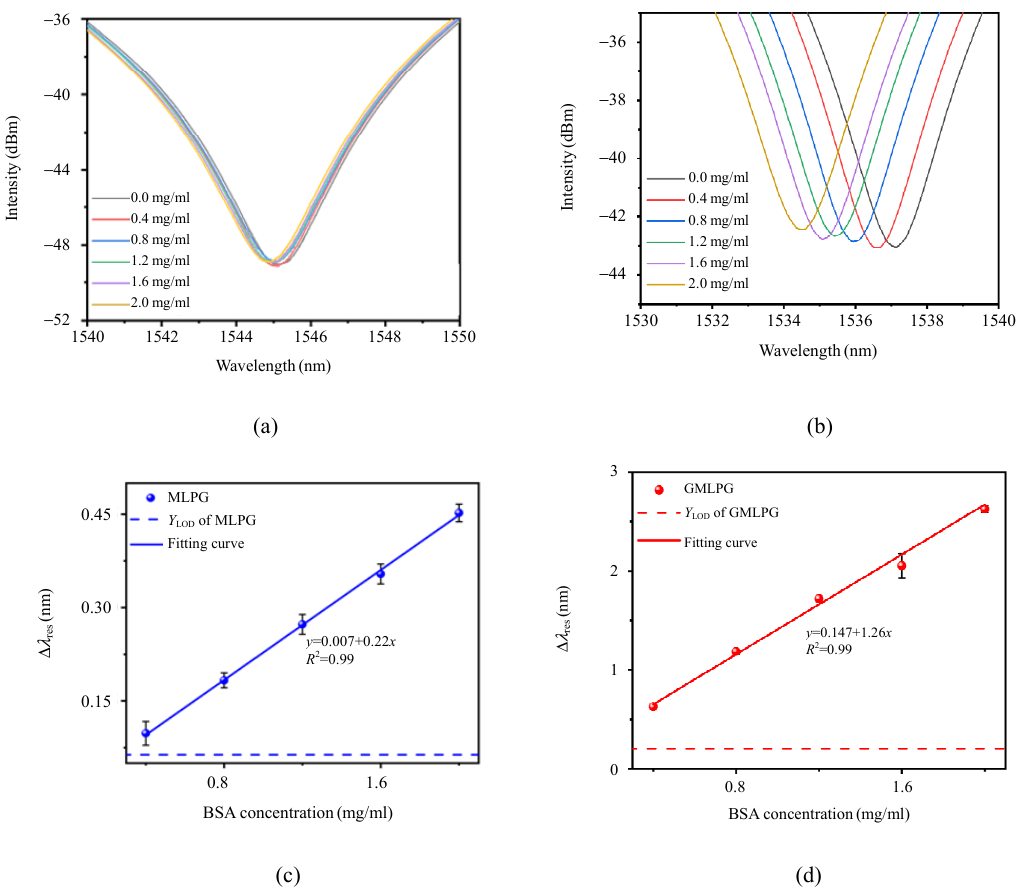
Fig. 4 Sensing spectrum and fitting results: (a) and (b) are the transmission spectra of the MLPG and GMLPG with different BSA λΔ against the BSA concentration in DI water by the MLPG and GMLPG, concentrations; (c) and (d) are the dependences of res respectively. The dash horizontal lines represent the three times of the standard deviation of blank